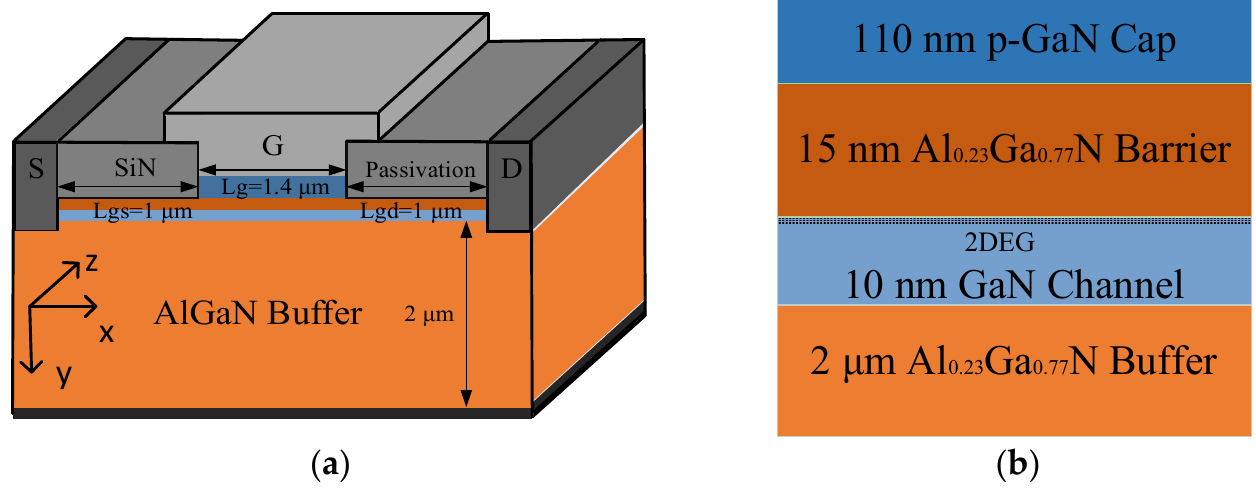
Figure 1. ( a ) Cross-sectional schematic of the enhancement-mode p-gate AlGaN/GaN HEMT; ( b ) partially enlarged view under the gate.